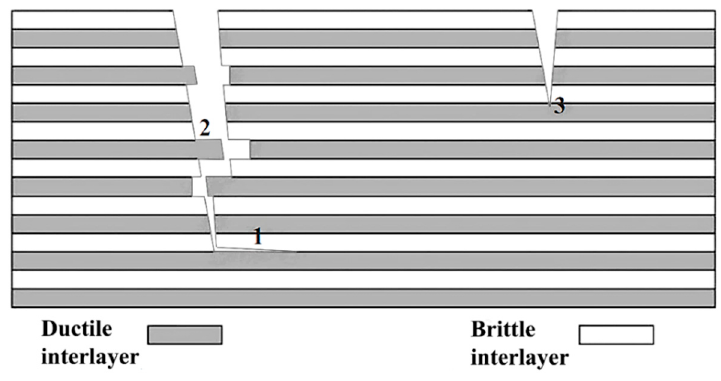
Figure 4. Toughening mechanisms: (1) crack deflection at the interfaces between layers; (2) coalescence of cracks at the interfaces; (3) crack tip blunting. Reprinted with permission from [69] 2005 Elsevier.